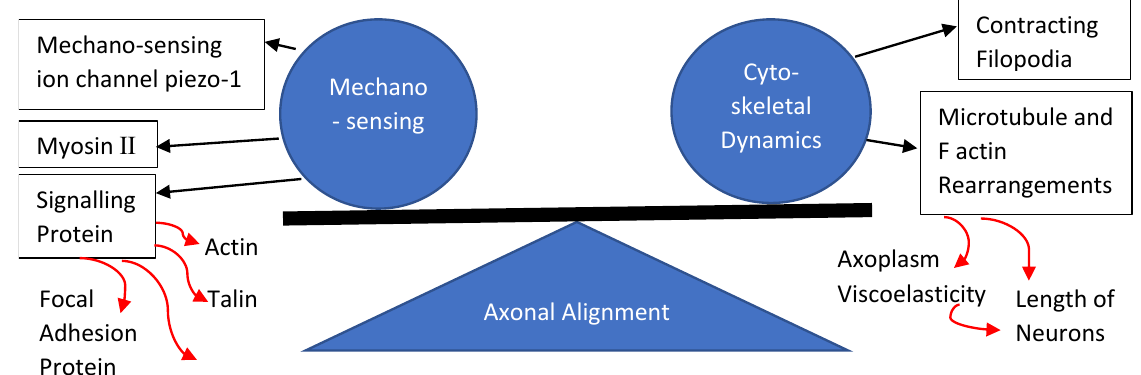
Figure 2. The process of axonal alignment in neural cells.